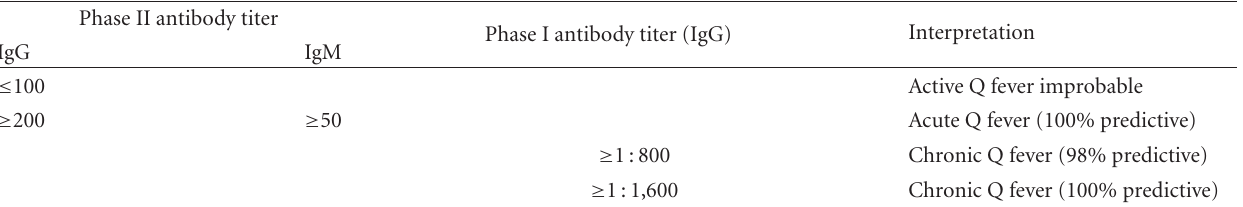
Table 1: Cuto ff proposal for Q fever diagnosis by using microimmunofluorescence and interpretation of serological results obtained with a single serum